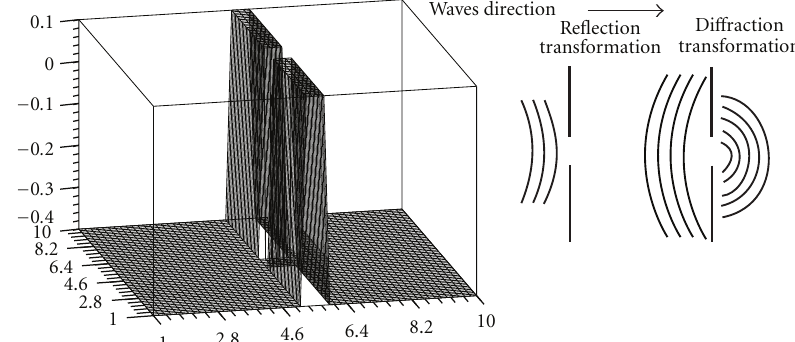
Figure 5: Di ff raction-Reflection diagram produced by two